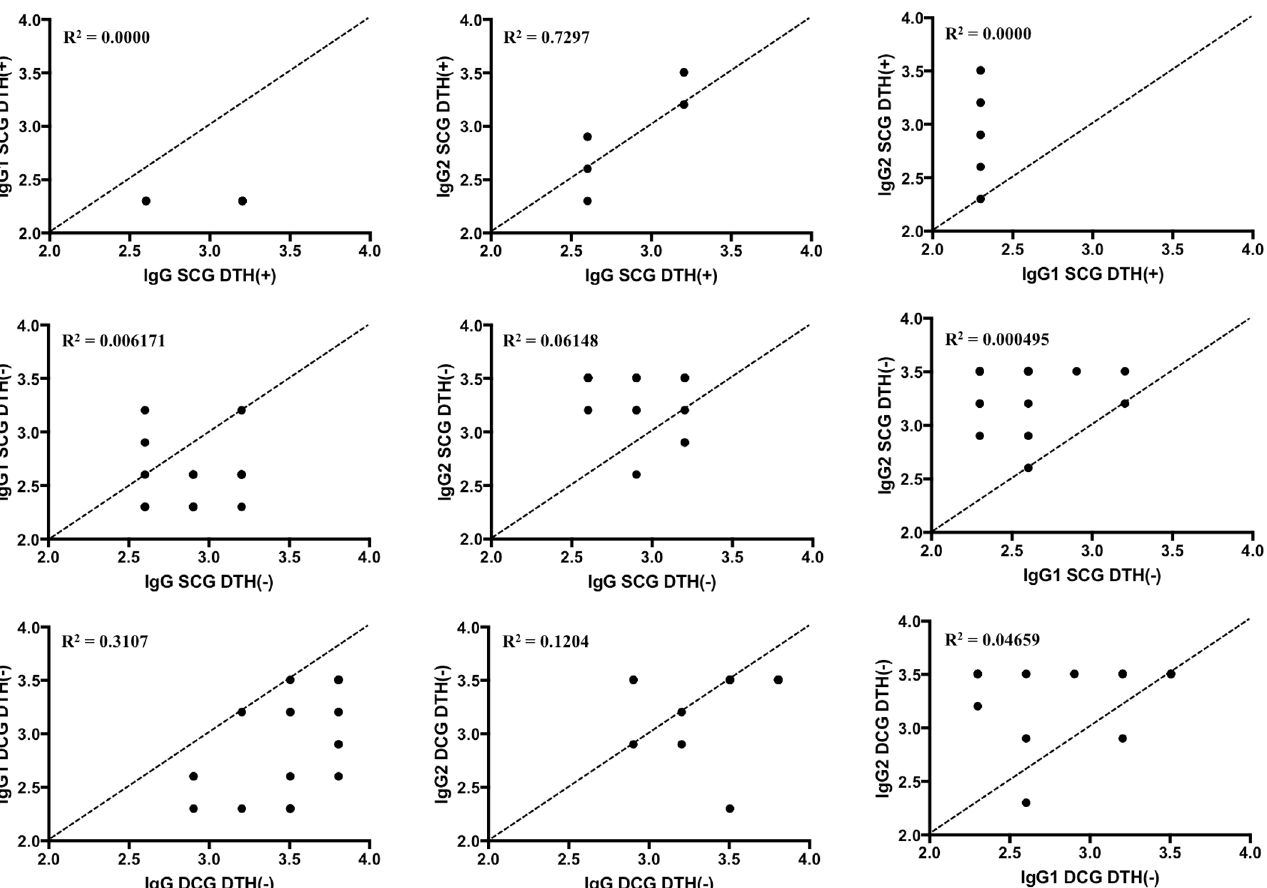
Figure 5. Correlations of log 10 transformations of IgG, IgG1, and IgG2 sera titer values of the SCG DTH ( + ) group (top), SCG DTH ( (cid:1) ) group (middle), and DCG DTH ( (cid:1) ) group (bottom) obtained using ELISA. The diagonal dashed line indicates what would be a perfect positive correlation ( r =1) between the variables.